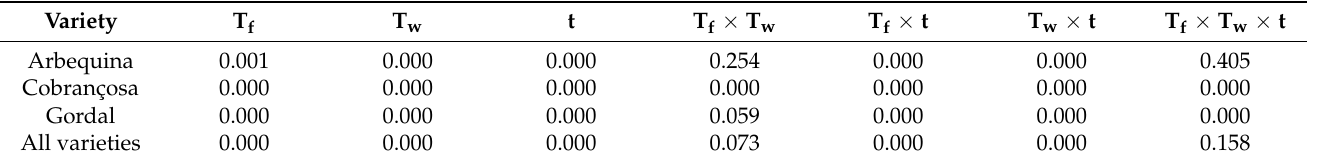
Table 2. Level of significance of the effect of the factors initial fruit temperature (T f ), temperature of the water (T w ), the time of immersion (t), and their interactions, on the fruit temperature for the three varieties (‘Arbequina’, ‘Cobrançosa’, and